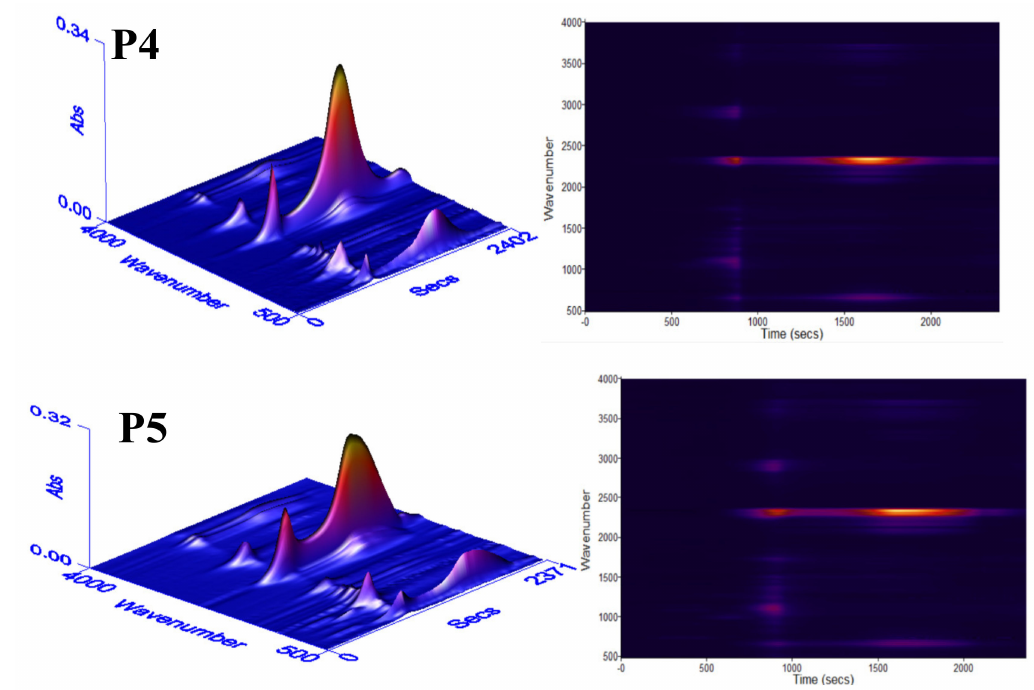
Figure 7. 3D FTIR spectra of escaped gases from the degradation of RPUF and RPUF / IL-EG / DPES.